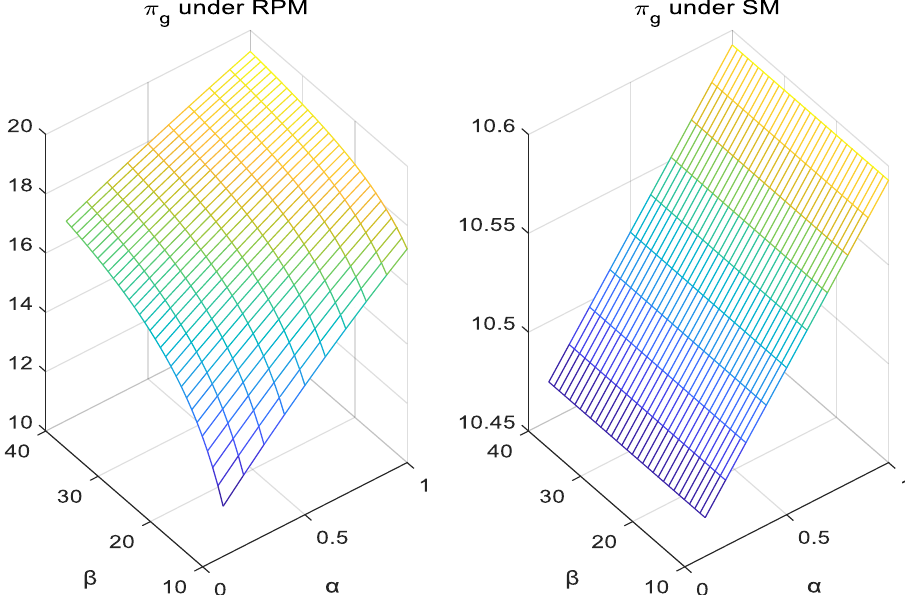
Figure 10. Social welfare vs. fixed cost coefficient and environmental benefit coefficient under RPM ( left ) and SM ( right ).